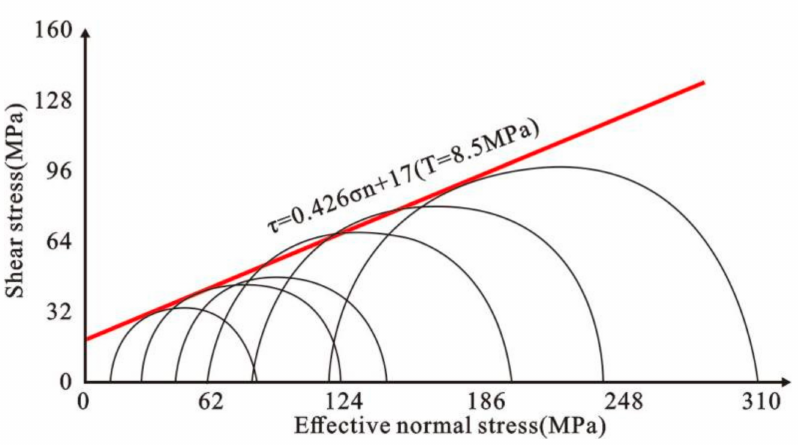
Figure 8. Mohr diagram plotting shear stress against effective normal